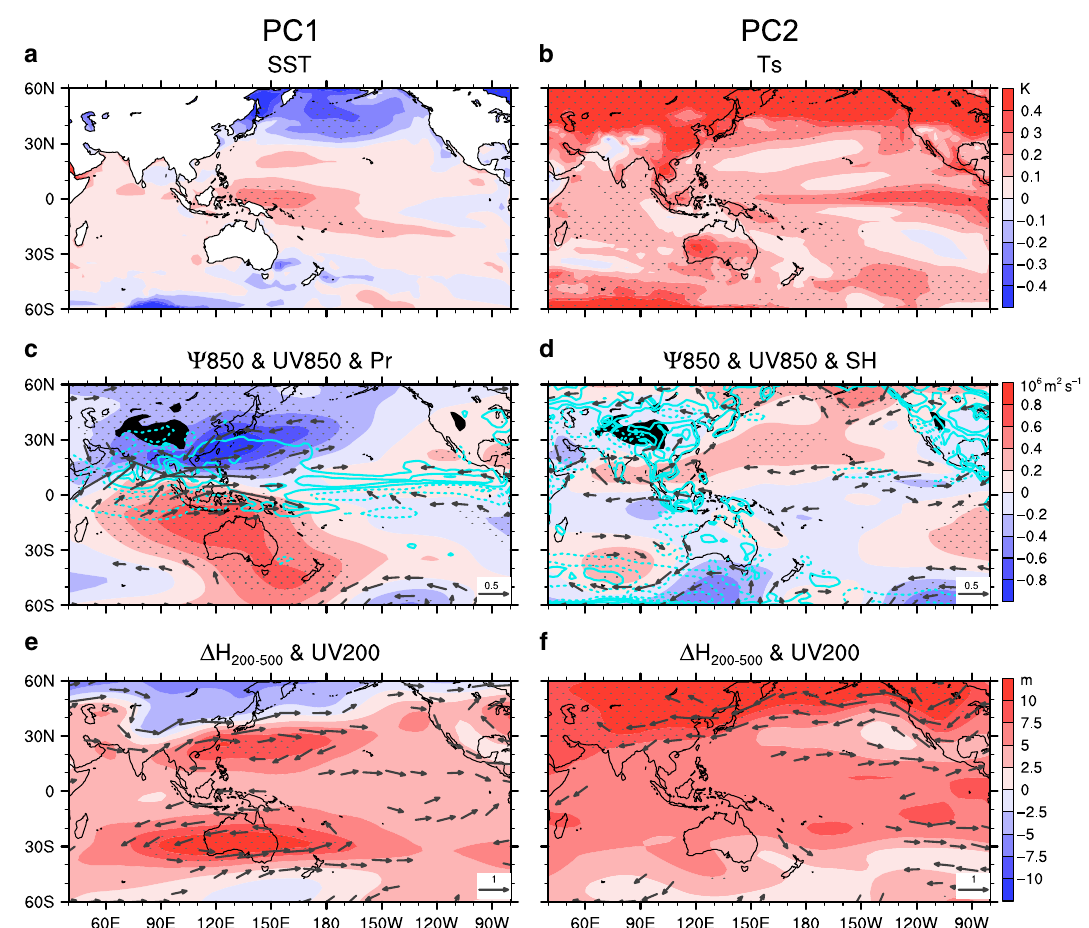
Fig. 5 Physical mechanisms related to model uncertainties in projection. a , c , e Intermodel spread in projected changes associated with the fi rst principal component (PC1) and b , d , f those associated with the second principal component (PC2). a , b Sea surface temperature (SST; shadings; K) and surface temperature (Ts; shadings; K), respectively. c , d Stream function ( ψ 850; shadings; 10 6 m 2 s − 1 ) and wind (UV850; vectors drawn for larger than 0.2 m s − 1 ) at 850 hPa, precipitation (Pr; contours in ( c ) drawn for ±0.2, ±0.6, and ±1.0 mm day − 1 ), and sensible heat fl ux (SH; contours in ( d ) drawn for ±0.6, ±1.8, and ±3.0 W m − 2 ). e , f Thickness ( Δ H 200 – 500 ; shadings; m) between 200 and 500 hPa and wind (UV200; vectors drawn for larger than 1 m s − 1 ) at 200 hPa. Dotted shadings are statistically signi fi cant at the 5% level under Student t -test. Uncertainty in the equatorial western Paci fi c warming in ( a ) leads to the fi rst uncertainty mode through the Gill-type response in ( c ) and ( e ) by triggering convective heating over the western Paci fi c in ( c ). Uncertainty related to changes in land – sea thermal contrast in ( b ) and associated sensible heating in ( d ) are responsible for the second uncertainty mode. Weakened subtropical jet stream in ( f ) is also manifested as a result of enhanced land – sea thermal